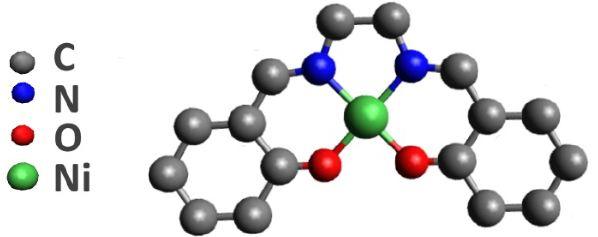
Figure 1. Schematic view of the [Ni(Salen)] complex without hydrogen atoms.